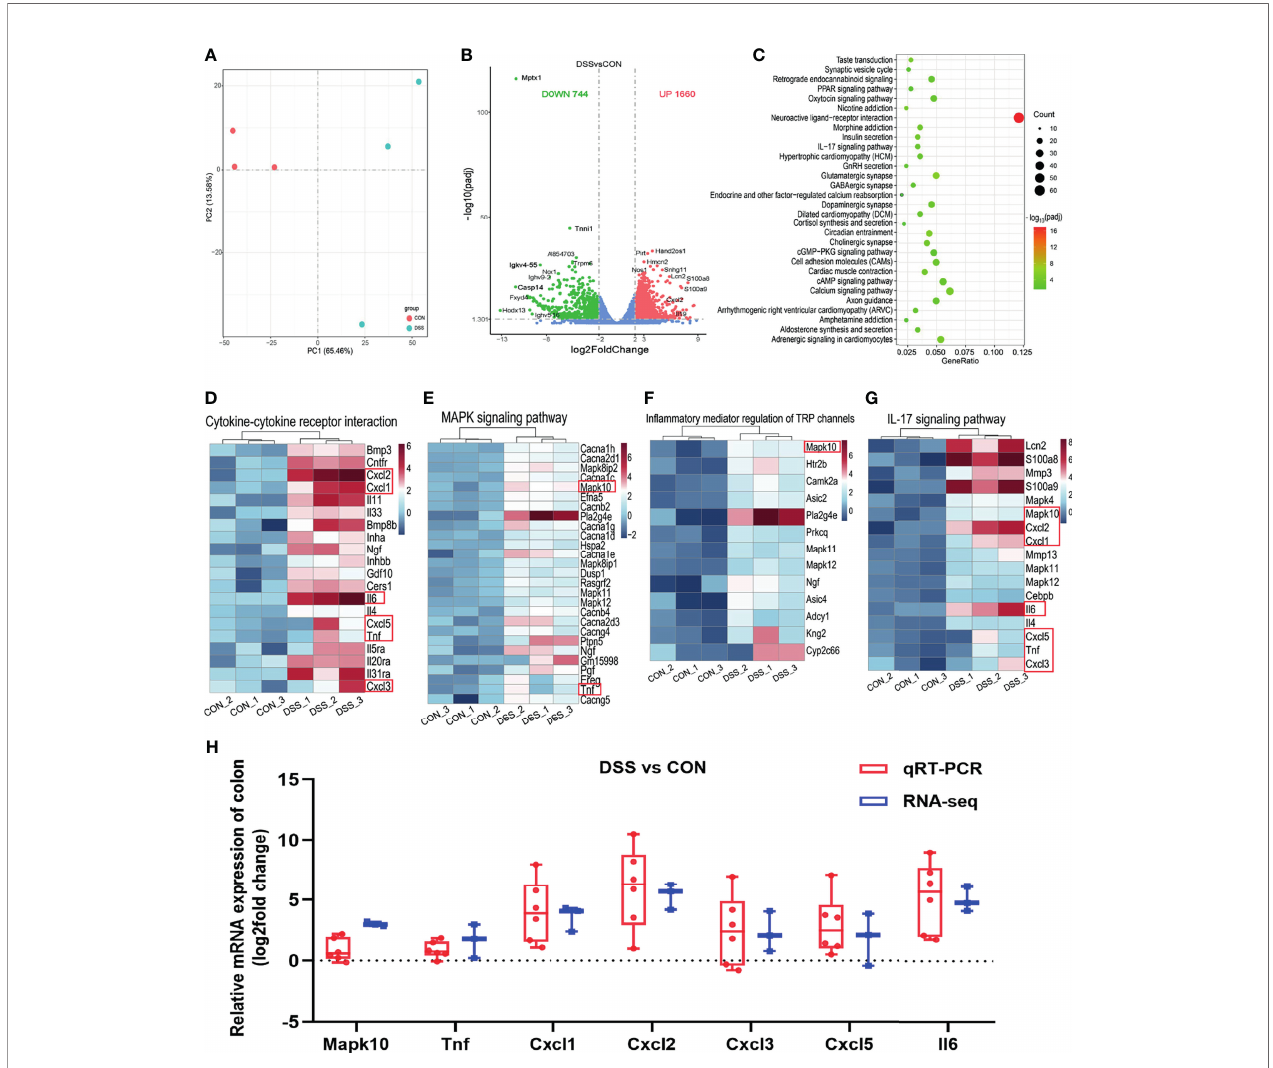
FIGURE 5 | Differentially expressed genes in the colon of healthy (CON) and acute colitis (DSS) mice. (A) PCA plot colored by DSS group samples in green and CON groups samples in red; (B) Volcano plot showing the changes of liver genes (fold change ≥ 2); (C) KEGG functional analysis reveals the top 30 biological functions that are enriched in the signi fi cantly up-regulated expressed genes; (D – G) Heatmap of 4 immune-related pathways enriched in the up-regulated expressed genes; (H) qRT-PCR (n=6) con fi rmations of DEGs screened based on RNA-seq analysis